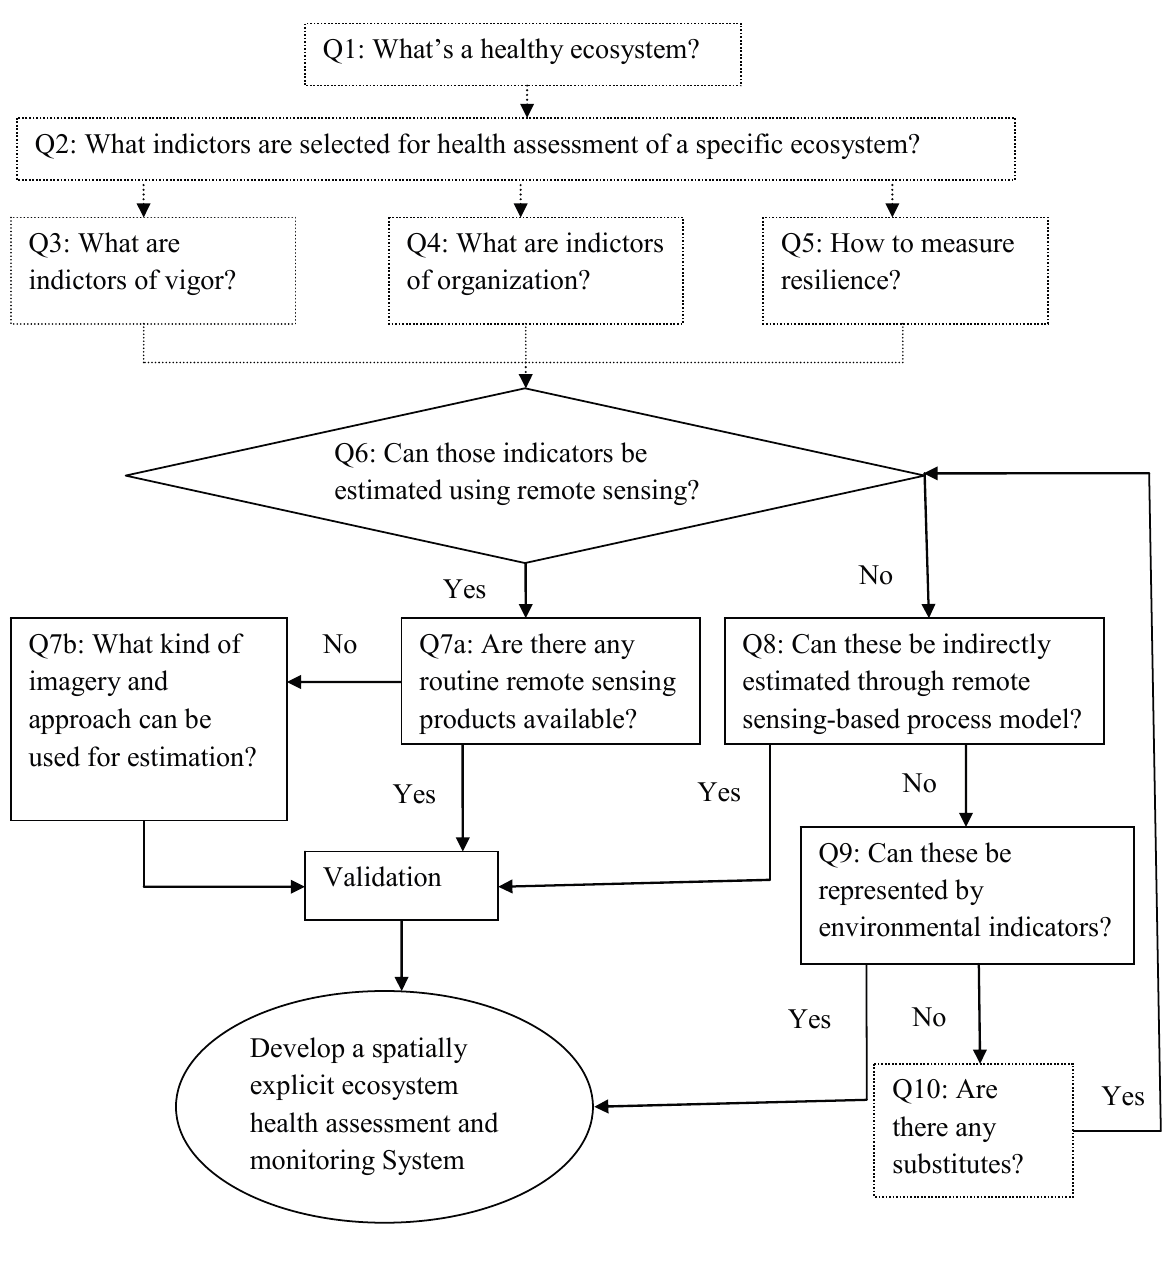
Figure 1. Procedures to integrate the expertise of remote sensing experts and ecologists to develop a remote sensing-based Ecosystem Health Assessment and Monitoring System. The questions outlined in dotted lines shows the contribution of